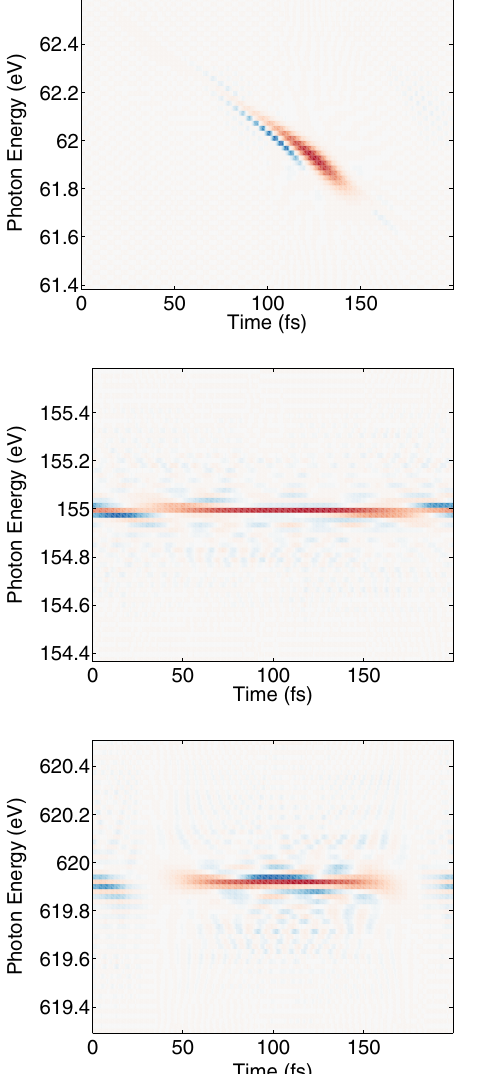
FIG. 10. Radiation characteristics for the combined EEHG and HGHG beam line of an initially flat beam subject to wakefields, showing power (top), phase (middle), and spectrum (bottom). Two separate wakefields are considered: a total energy deviation of (cid:2) 2 keV induced within the EEHG stage (solid red), or a gradient ranging between (cid:2) 7 keV = m beginning from the end of the EEHG stage (dashed